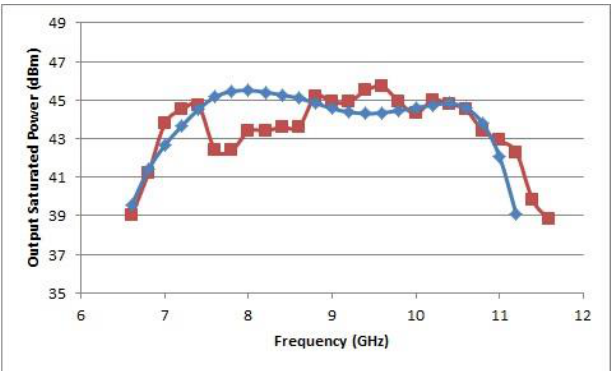
Figure 11: Saturated power output for amplifier operating between 8-10 GHz. Blue line: simulation, red line: measurement